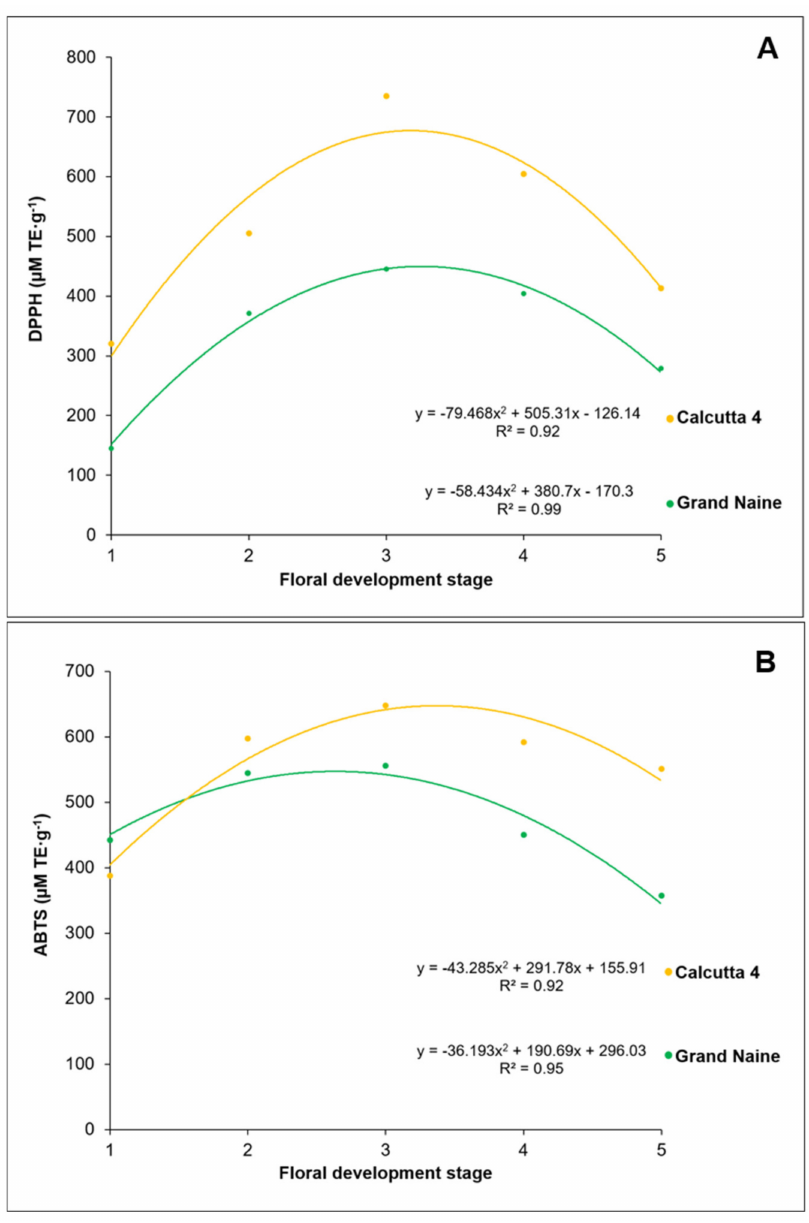
Figure 2. 2,2-Diphenyl-1-picrylhydrazyl (DPPH) ( A ) and 2,2 (cid:48) -azinobis-(3-ethylbenzothiazoline-6- sulfonic acid) (ABTS) ( B ) radical scavenging activity at different stages of floral development of the nectary in Calcutta 4 and Grand